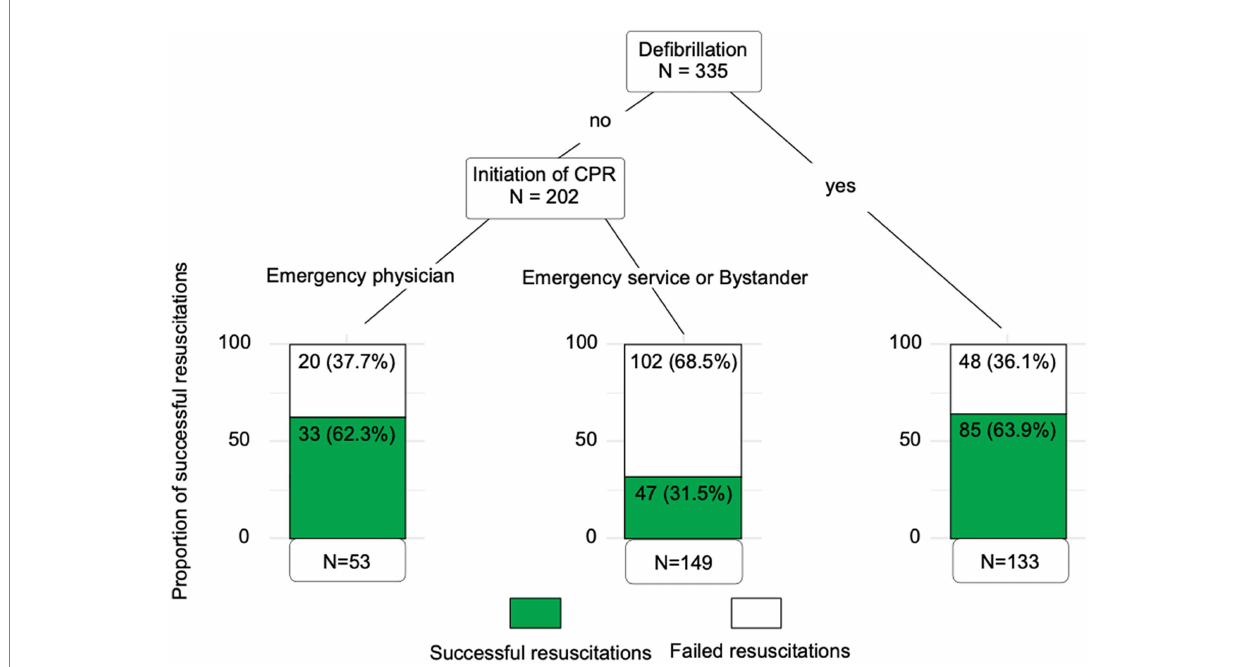
FIGURE 2 Classification tree. Classification tree depicting the outcome of resuscitations. Independent variables of the classification tree were defibrillation, initiation of CPR, initial rhythm, age, location of the OHCA, and delay. The parameters of the classification tree were a minimum number of 30 patients per node to be further split and a minimum number of 20 patients per end node. Defibrillation was found as the first node, and if defibrillation was not performed, a second node was found in the group that started resuscitative efforts. The highest chances of successful resuscitations were found in patients where defibrillation was performed. The lowest chances of successful resuscitations were found in 149 patients where defibrillation was not performed and where CPR was started by emergency services or